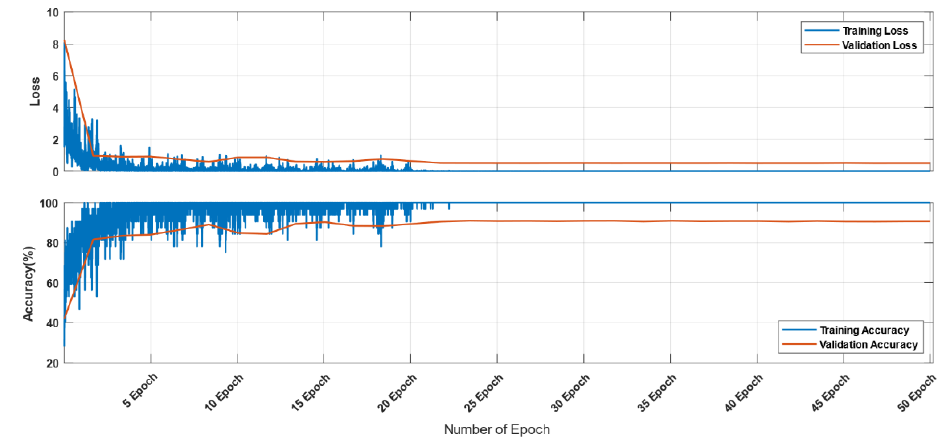
Figure 12. Convergence curve of loss during train process for 4 class classification using front-wheel data.